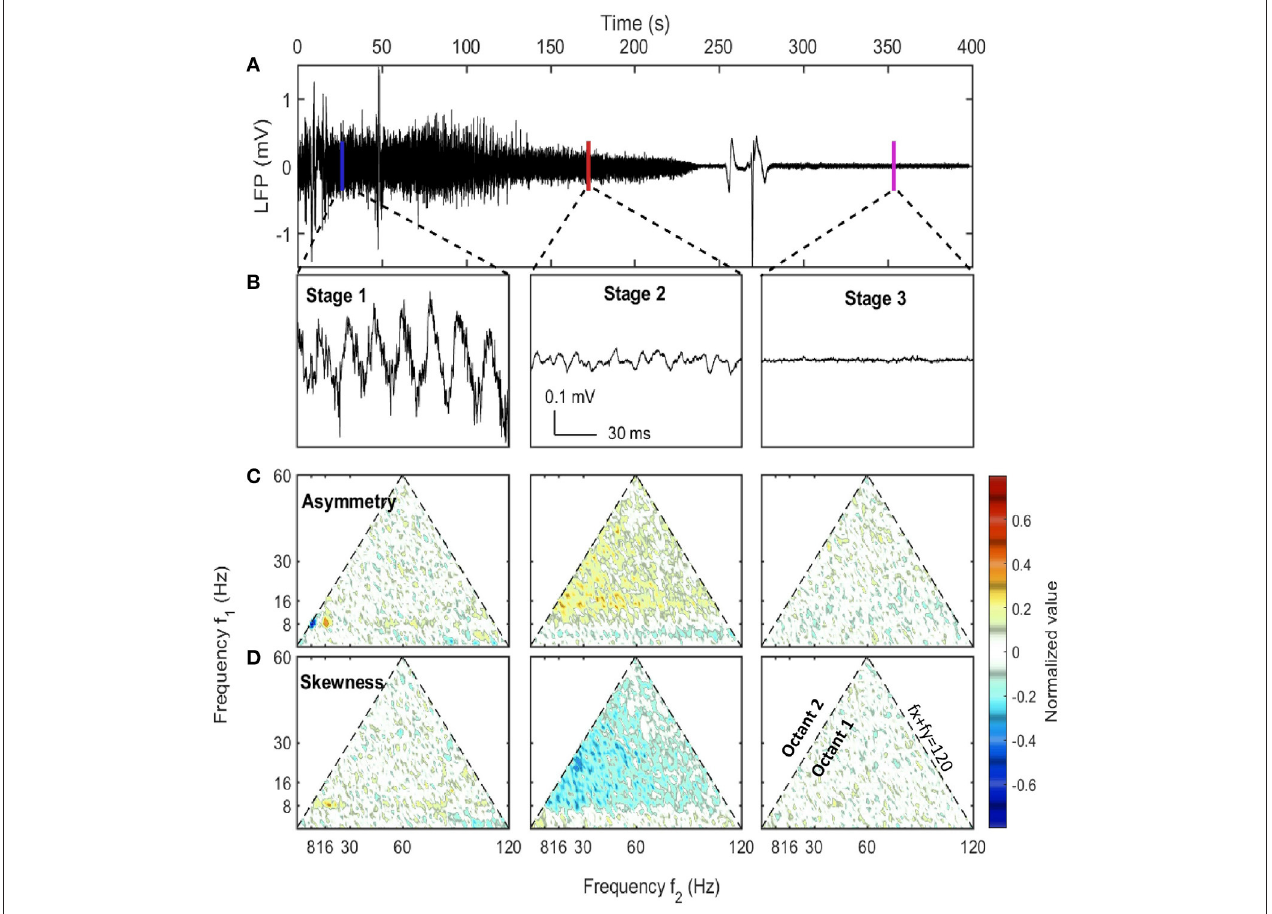
FIGURE 1 | LFP examples at different stages along with their asymmetry and skewness. (A) The raw LFP trace recorded in CA1 pyramidal layer after the injection ( t = 0) which showed the overall neural activity evolution during euthanasia. (B) LFP samples of 1 s selected from three stages. The corresponding windows were indicated in (A) . (C,D) The asymmetry and the skewness of LFP at three stages obtained from bispectral analysis (Haubrich and MacKenzie, 1965; Masuda and Kuo, 1981; Sheremet et al., 2016). Both the horizontal axis and the vertical axis represent frequency. Each point in the plot was the asymmetry or skewness estimated for the frequency triad (cid:0) f x , f y , f x + f y (cid:1) . Only the first octant ( f x ≥ 0, f y ≥ 0, f x ≥ f y ) is presented as it contained all the non-redundant information due to the symmetry of bispectrum. The first octant is bounded by the dashed line f x + f y = 120 Hz indicating the upper bound of frequency range of interest. An oscillation has asymmetry if the wave peak or trough doesn’t stand at the center of adjacent zero-across points. An oscillation has skewness if the wave height distribution is not symmetric about its mean value. Both asymmetry and skewness indicate cross-frequency coupling. Data from rat